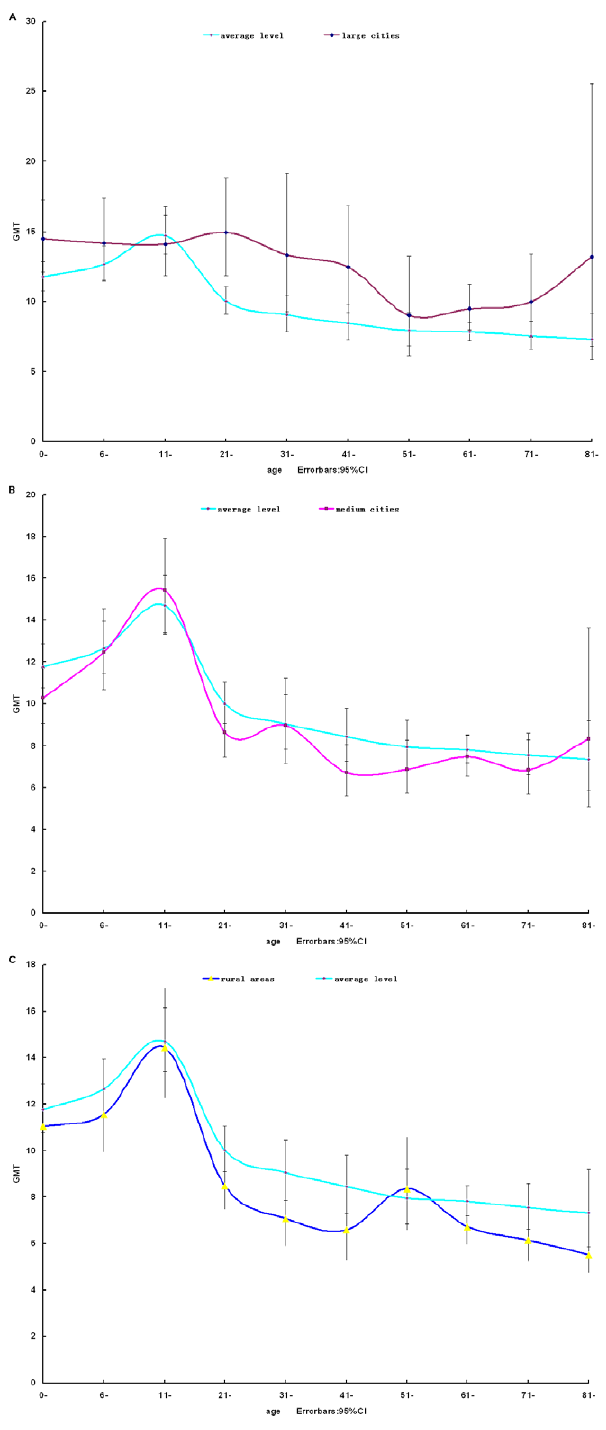
Figure 2. Antibody titers to A/California/7/2009 by HI. Serum samples collected from large cities, medium cities and rural areas, respectively, were tested by HI assay. The GMTs were plotted according to the age distribution. The 95% CI for individual HI GMTs were shown as error bars.